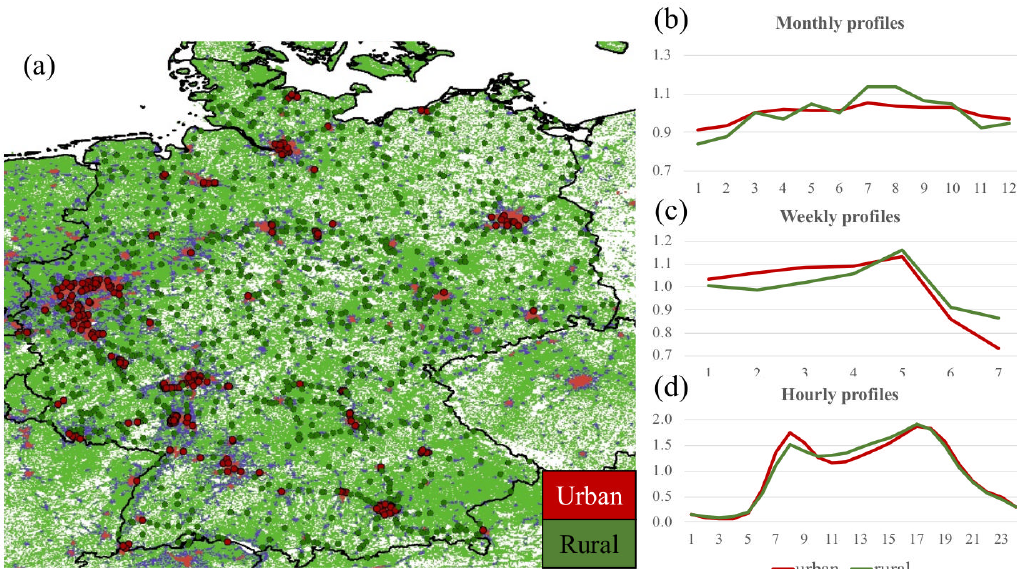
Figure 3. Map representing urban and rural human settlements in Germany as reported by the Global Human Settlement Layer (GHSL; Pesaresi et al., 2019) and the location of urban and rural German traffic count stations (a) and monthly, weekly and hourly temporal profiles derived from averaging the original traffic counts (BASt, 2018) by the type of station (b, c, d) . Administrative boundaries are derived from GADM